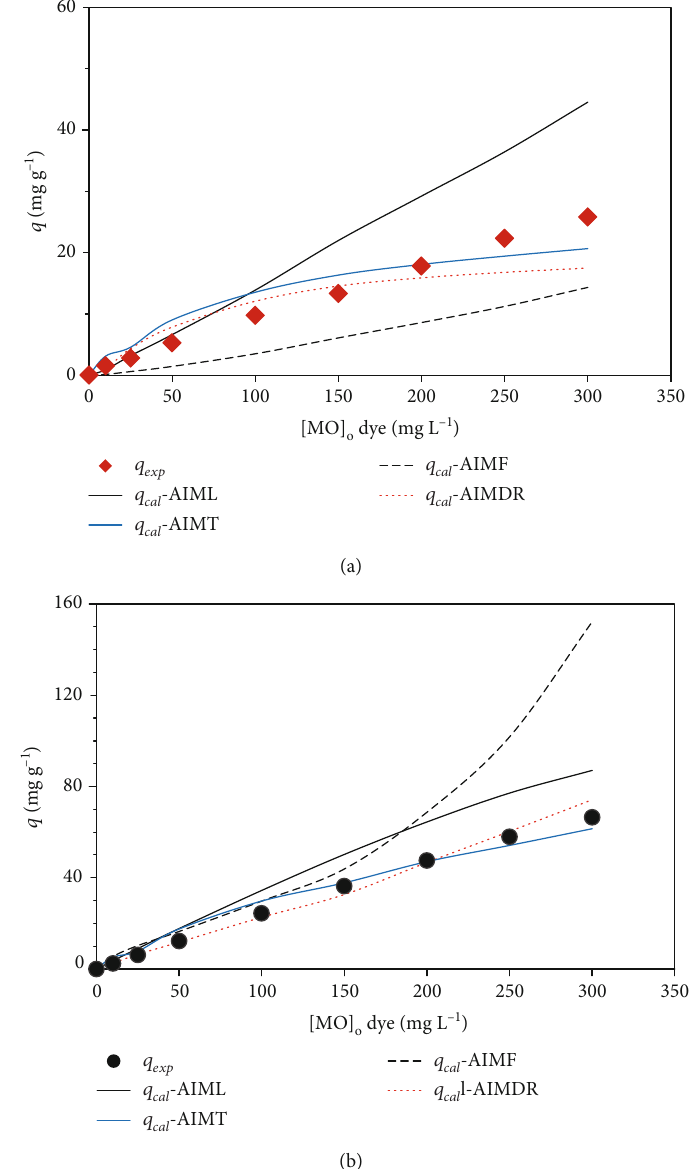
Figure 10: The impact of [MO] on the amount of MO adsorbed in (a) AlgN and (b) AlgN-CTAB based on experimental results ( q o estimation using the AIML, AIMF, AIMDR, and AIMT